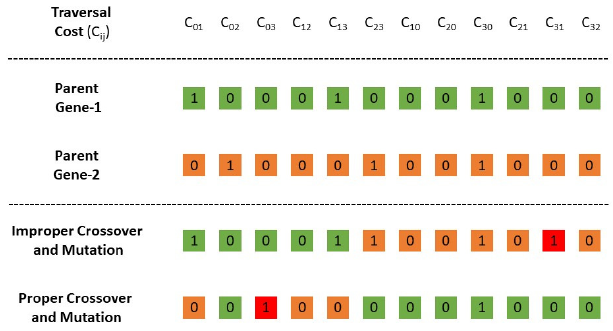
Figure 7. Illustration for a sample run of flight path